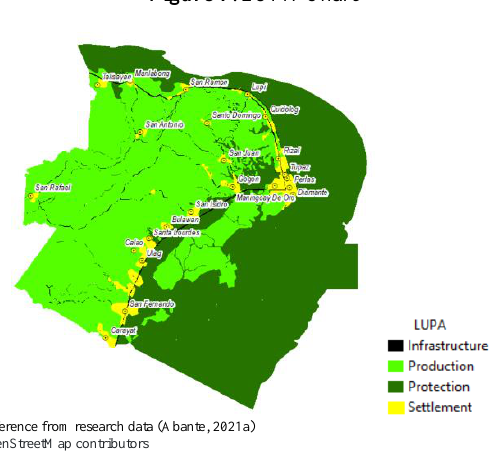
Figure 8 . LUPA Map, 2021